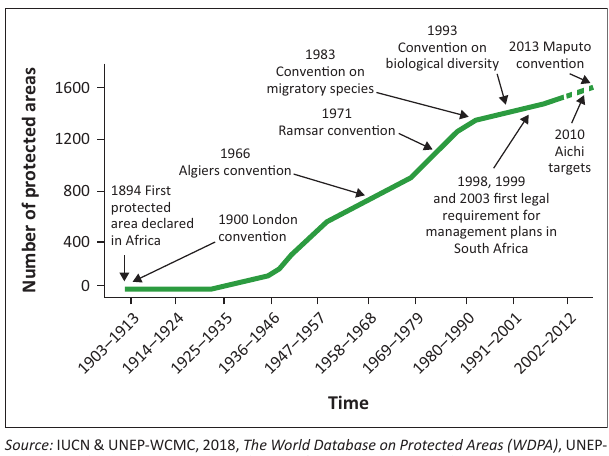
FIGURE 1: A schematic representation of the accumulation of protected areas (South Africa), together with a timeline of the occurrence of key events that may have influenced the evolution of protected area management